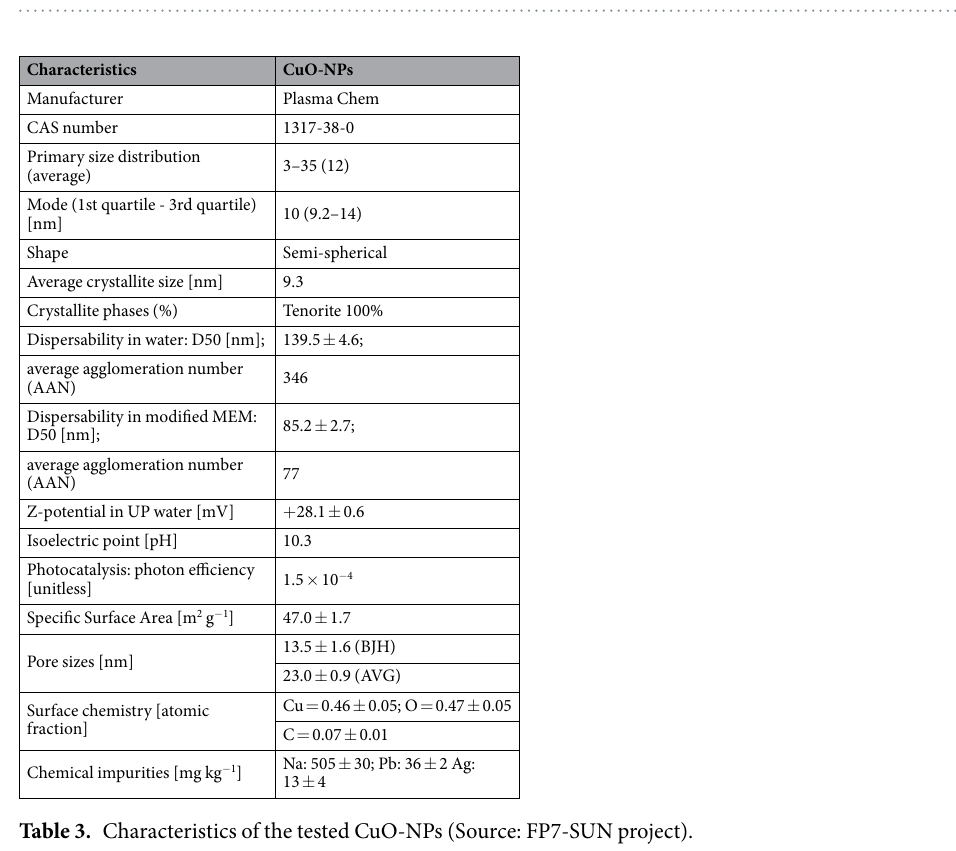
Figure 3. Schematic representation of the proposed Lifespan test for Enchytraeus crypticus , including the pre- exposure period (synch and hatching), the sampling days and endpoints evaluated (survival and reproduction) over the test duration.